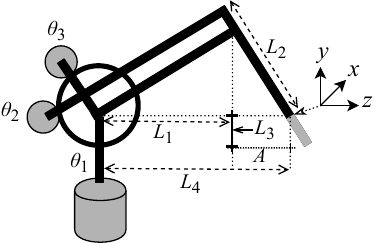
Figure 25. Structure of 3-DOF Phantom Omni robotic manipulator.